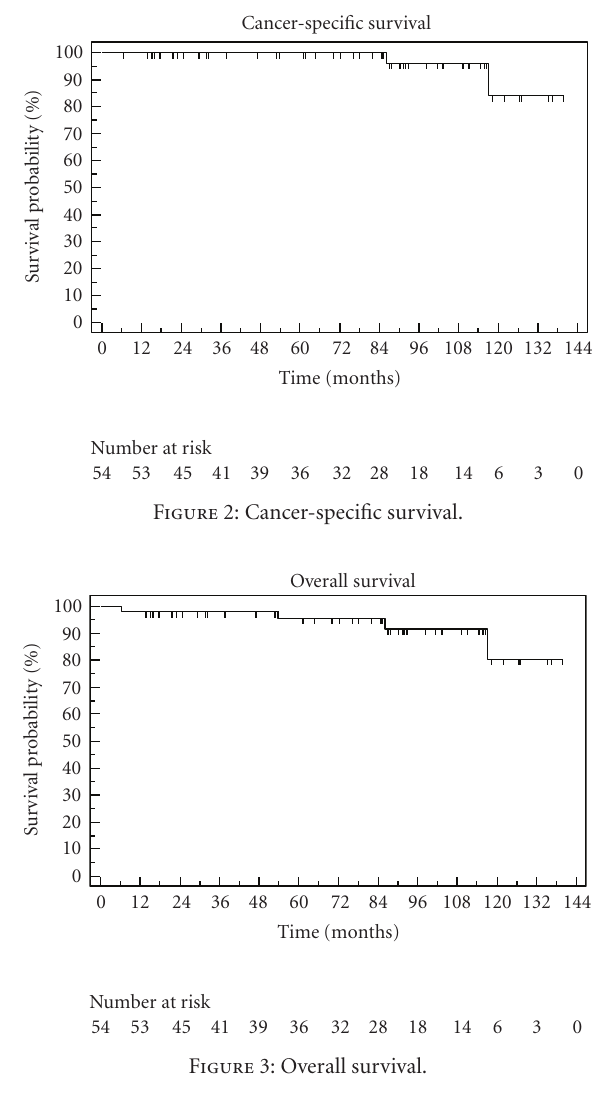
Figure 3: Overall